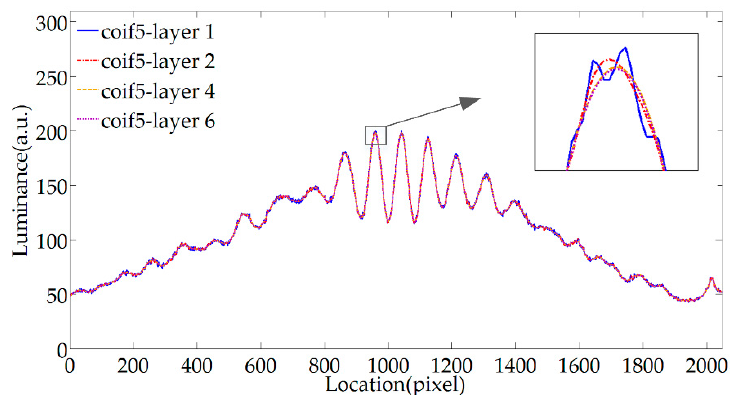
Figure 6. Filtering effect of different decomposition layers.